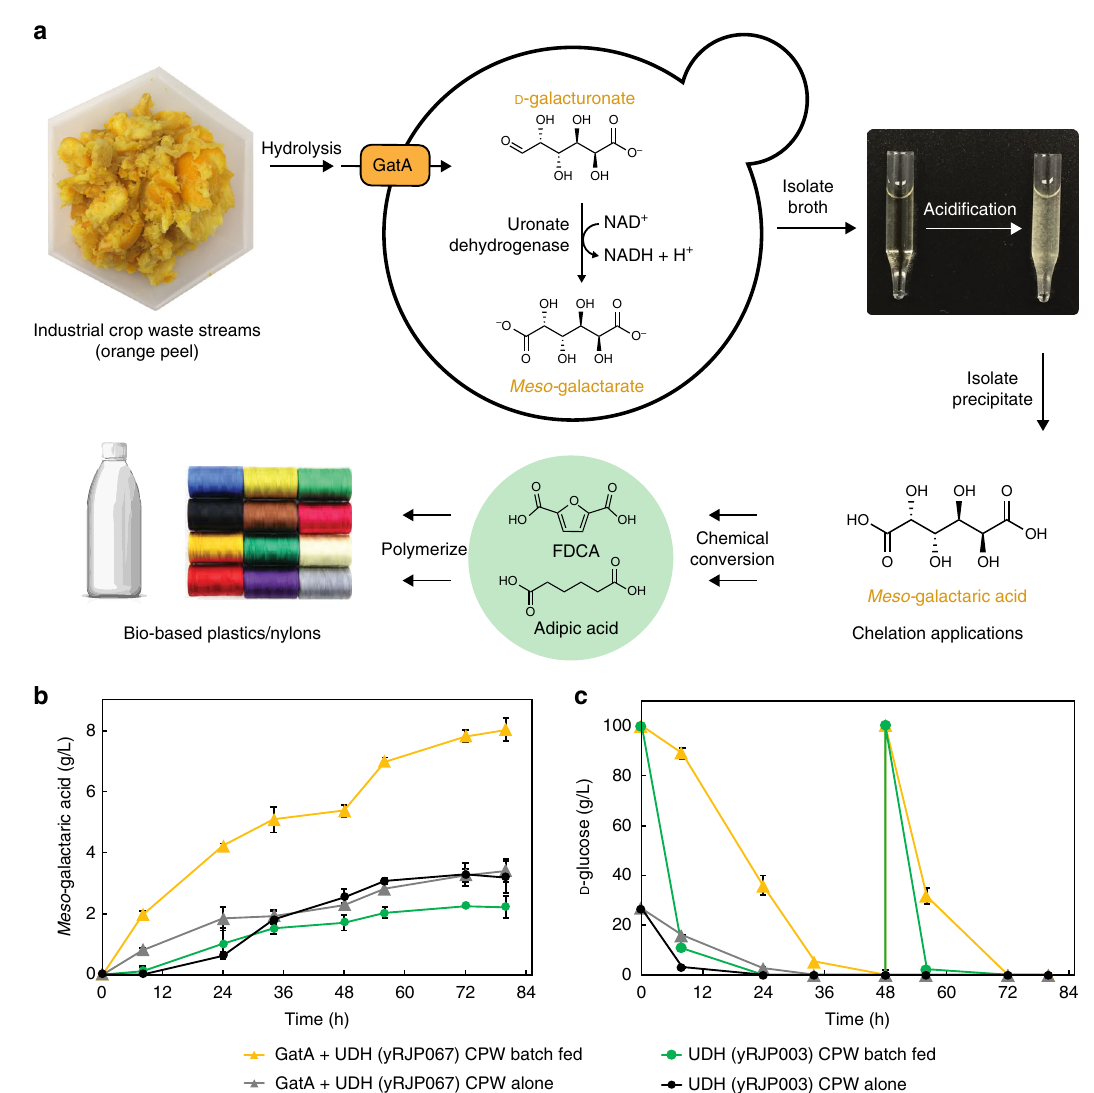
Fig. 4 Production of meso -galactaric acid from citrus peel by engineered S. cerevisiae . a Citrus peel is enzymatically depolymerized to yield an acidic hydrolysate containing D -galUA and D -glucose. GatA transports D -galUA intracellularly in the presence of D -glucose. UDH oxidizes D -galUA to meso- galactarate, which accumulates in the media and is precipitated by acidi fi cation of the broth. Meso- galactarate is used directly as a renewable chelate and pharmaceutical conjugate. Ef fi cient chemical conversions of meso -galactaric acid yield nylon and plastic monomers, adipic acid and 2,5-furandicarboxylic acid (FDCA), for polymerization and broad commercial applications. b Strains co-expressing UDH and GatA (yRJP067, triangles) exhibit higher conversion of D -galUA to meso- galactaric acid in acidic orange peel hydrolysate media in the presence of glucose compared to strains expressing only UDH (yRJP003, circles). Batch feeding of D -glucose ( c ) at 0 and 48 h in CPW hydrolysate cultures increases meso- galactaric acid yields when expressing GatA (orange triangles), but inhibits yields without the transporter (green circles). Concentrations are normalized for glucose batch feeding. Error bars represent standard deviation of biological triplicates. Image sourced from Petr Kratochvil and licensed under CC0 1.0 Universal Public Domain Dedication by